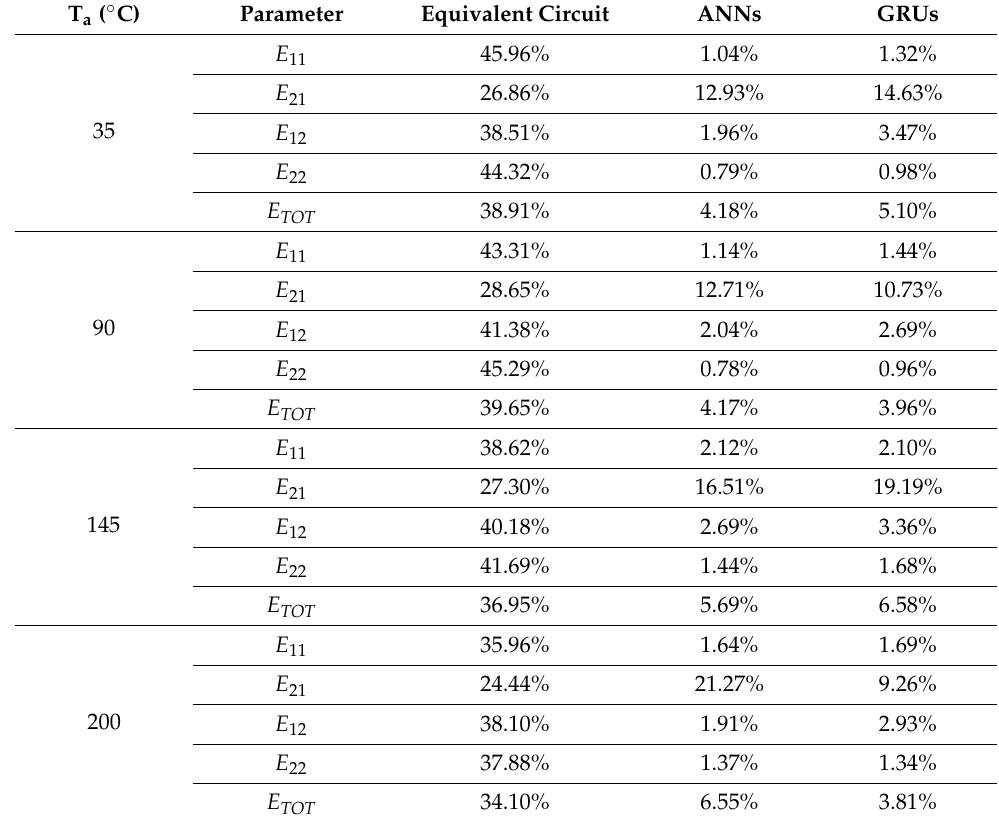
Table 3. Percentage errors between measured and modeled scattering parameters with the frequency range spanning from 200 MHz to 65 GHz for the DUT at V DS = 30 V and V GS = − 3.1 V, with four different values of T a . Three models are considered: Equivalent circuit, ANNs, and